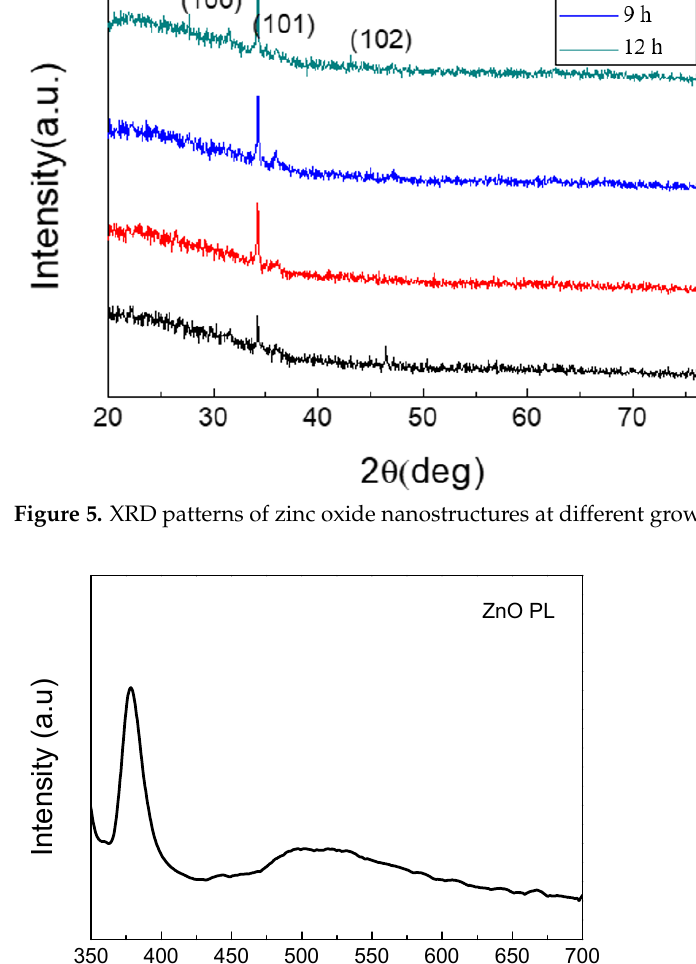
Figure 7. Sensitivity measurements of graphene/zinc oxide nano-heterostructures to different H 2 concentrations at 250 °C.